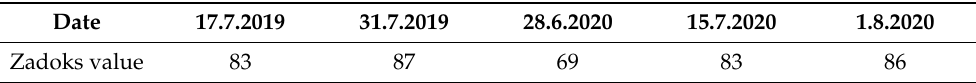
Table 1. Zadoks value for barley during the research time.